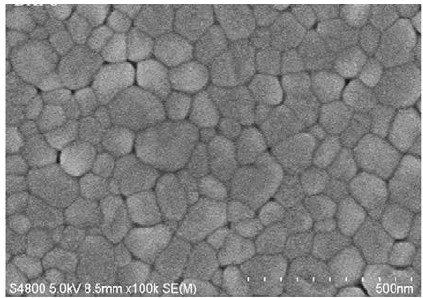
Figure 17. Topography of BFO film produced by the sol gel method [30].